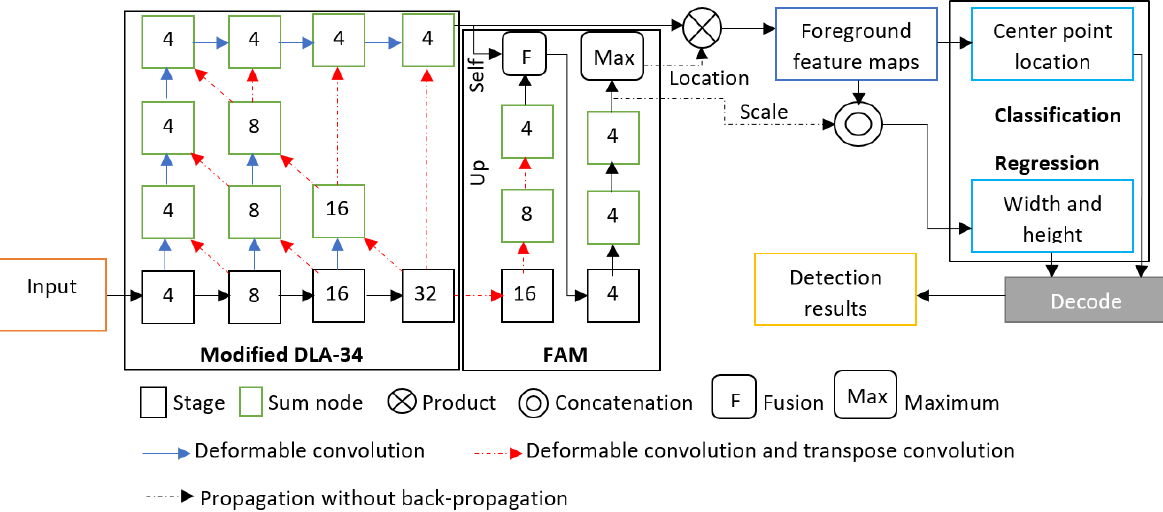
Figure 1. The proposed FAM-centerNet. The numbers inside the boxes refer to the stride of the image. Modified DLA-34 was introduced using deformable convolution to change channels and transpose convolution for upsampling.